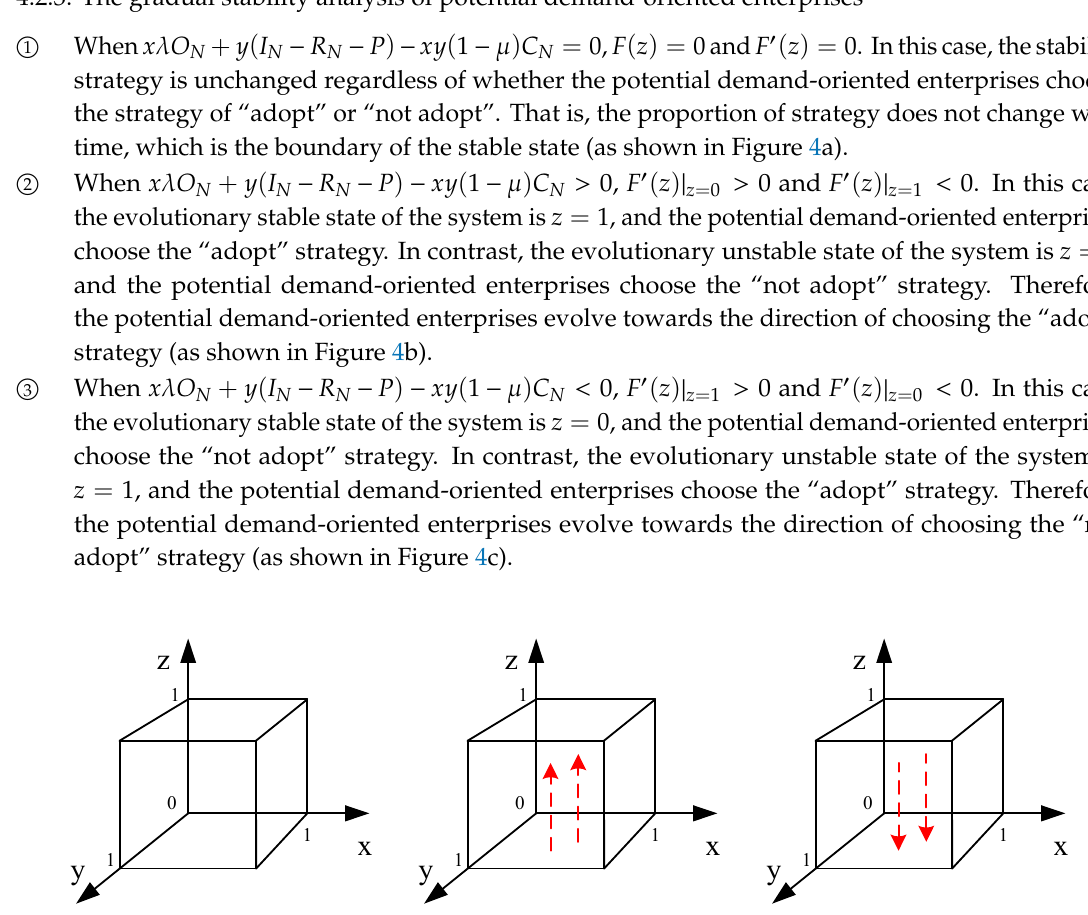
Figure 3. Dynamic evolution trend chart of innovation-supplying enterprises.